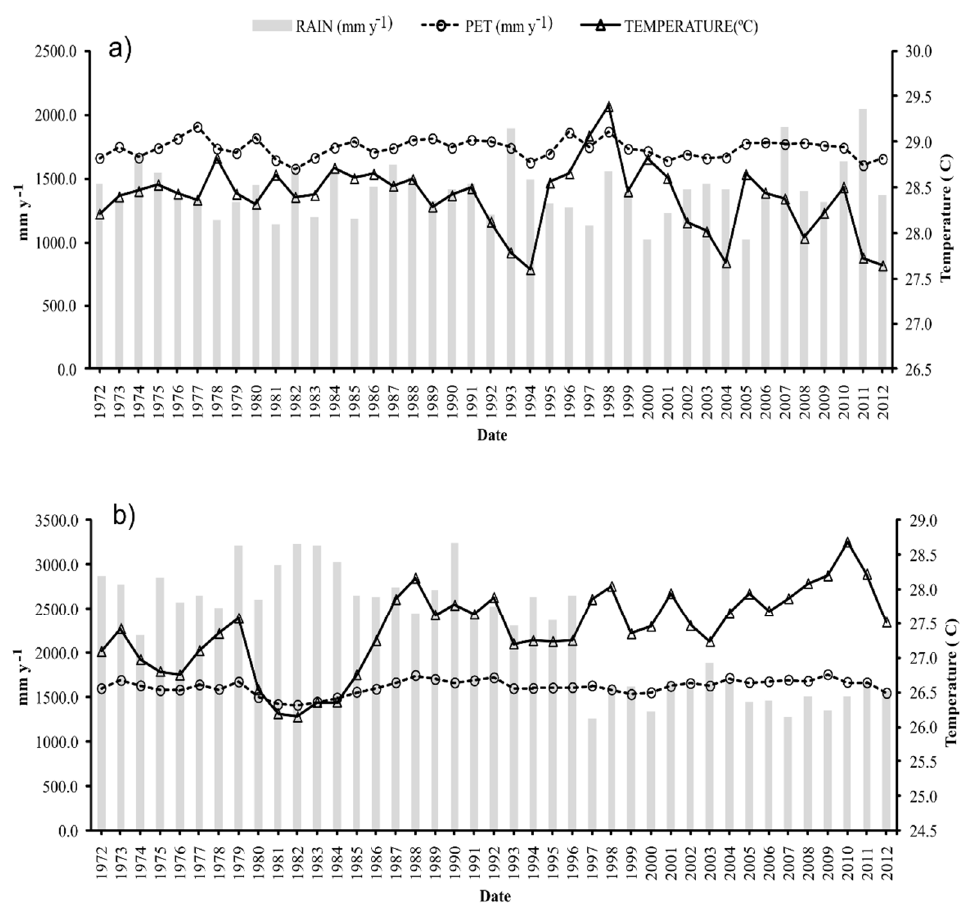
Figure 4. Annual precipitation (mm year −1 ), PET (mm year −1 ) and temperature (°C) in the period of 1972–2012 for the Barinas ( a ) and Turen ( b ) weather stations.